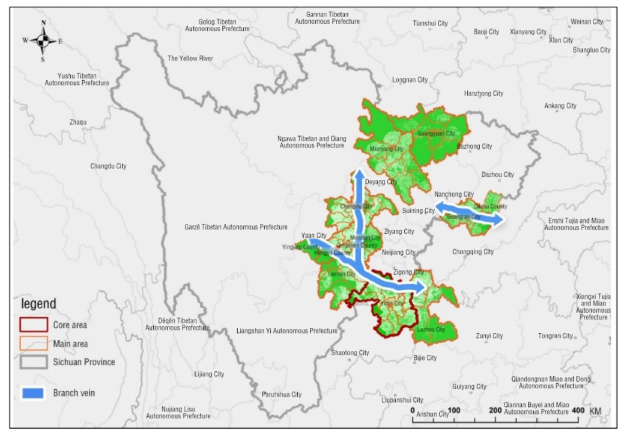
Figure 26. Distribution of branch veins of research areas in Sichuan